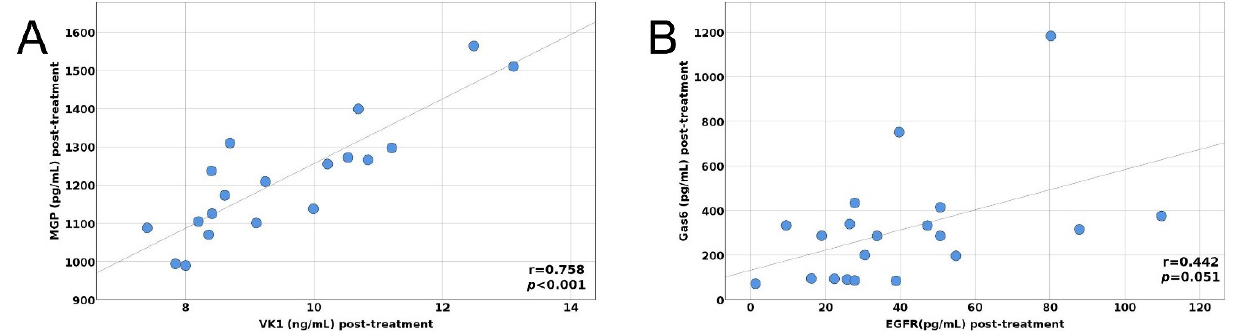
Figure 2. ( A ) Post-treatment correlation between MGP and VitK 1 , ( B ) Post-treatment correlation between Gas6 and EGFR.